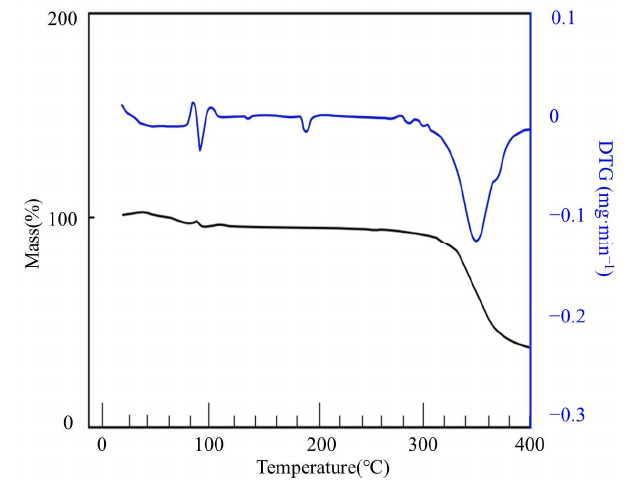
Figure 4. The TG and DTG curves of starch.